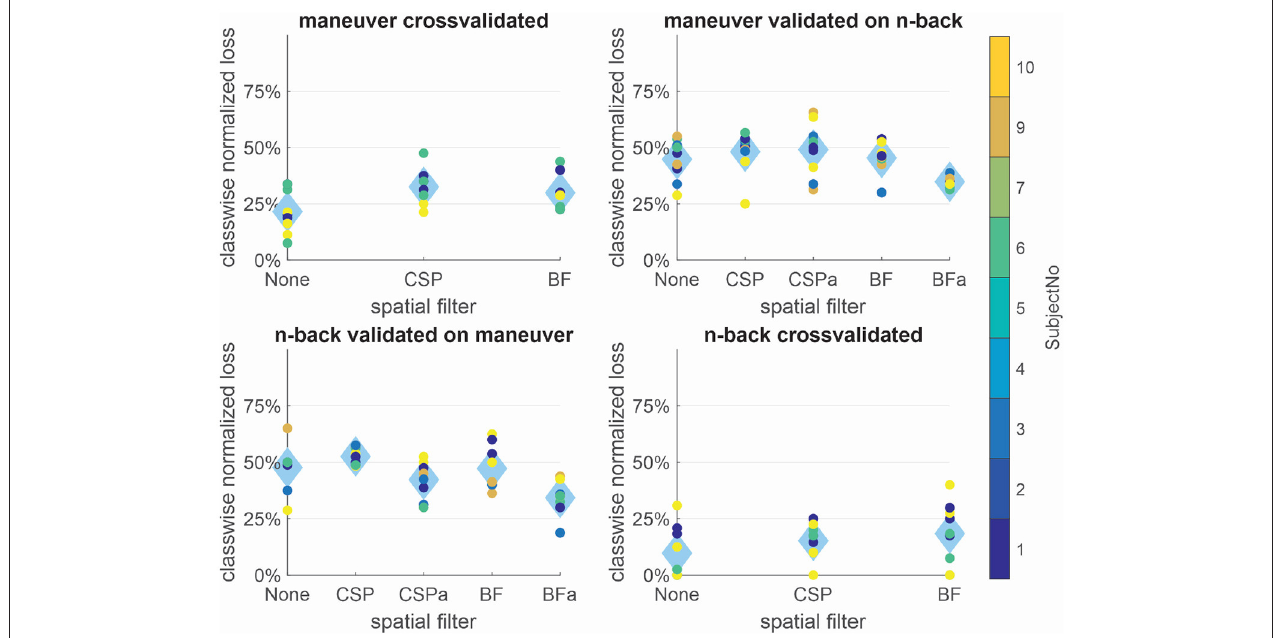
FIGURE 1 | Within and between condition class-wise normalized losses for different spatial filtering approaches: Within conditions no spatial filtering leads to the lowest errors, while for the transfer between conditions, the non-data-dependent patterns of beamforming in combination with a constant adaptation is the only reliable approach. Dots show results for single subjects, while diamonds depict the average over